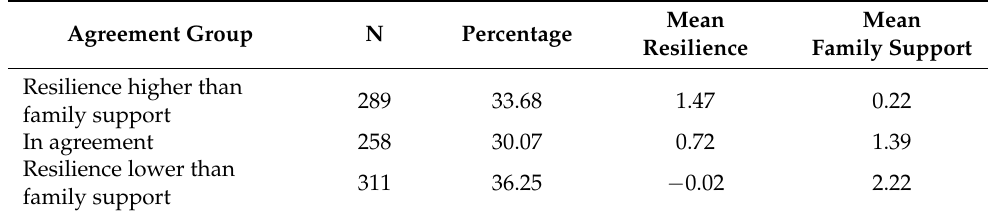
Table 3. Frequencies of resilience levels over, under, and in agreement with family support